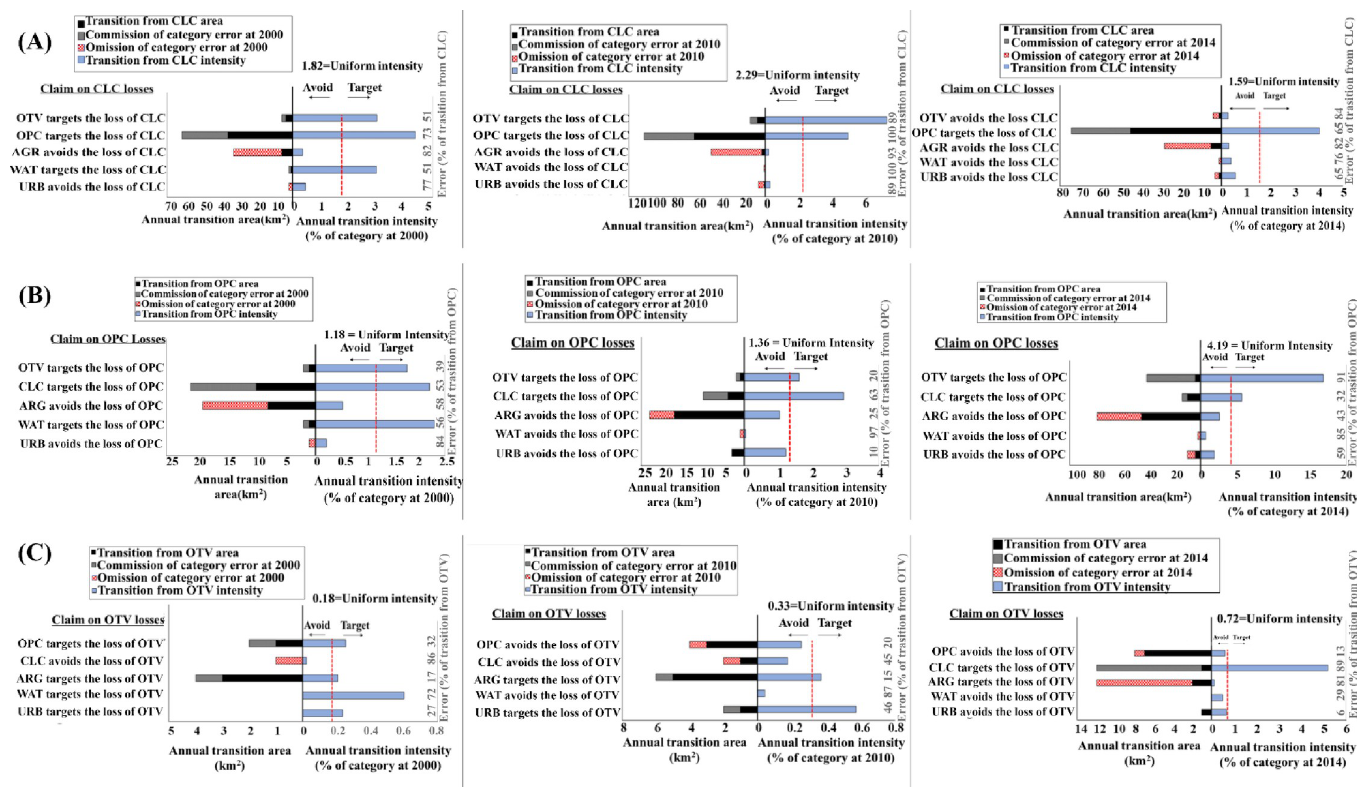
Fig 6. Intensity analysis for transition from CLC, OPC and OTV, given CLC, OPC and OTV observed losses during 1990–2000, 2000–2010 and 2010–2014.